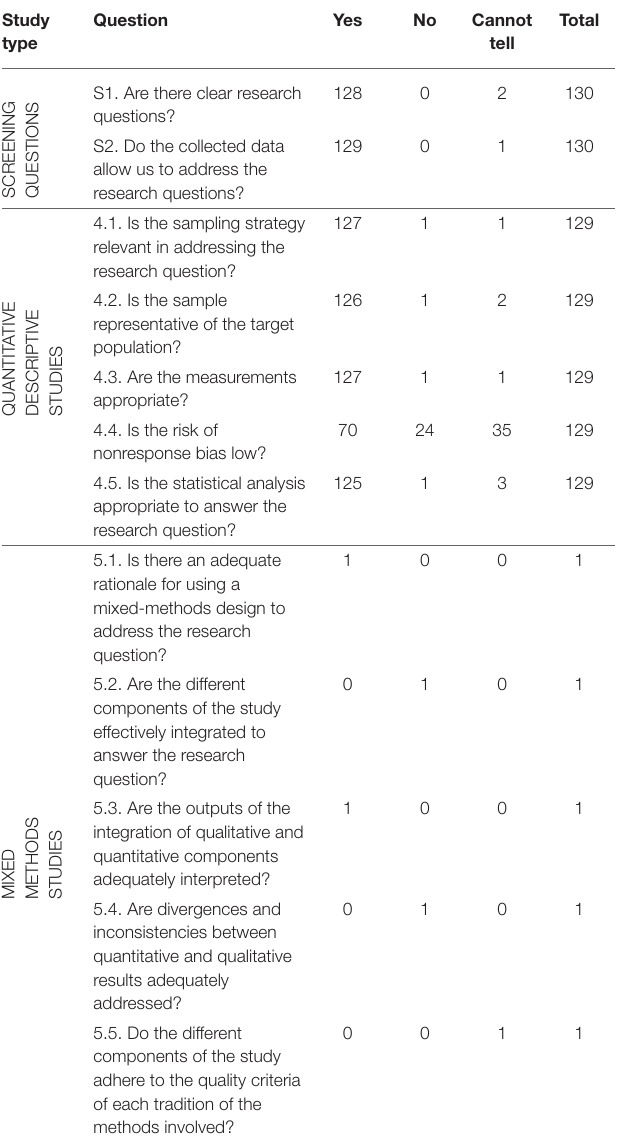
TABLE 3 | MMAT table for Sub-Saharan African studies on the burden of cervical, breast and prostate cancer. Study type